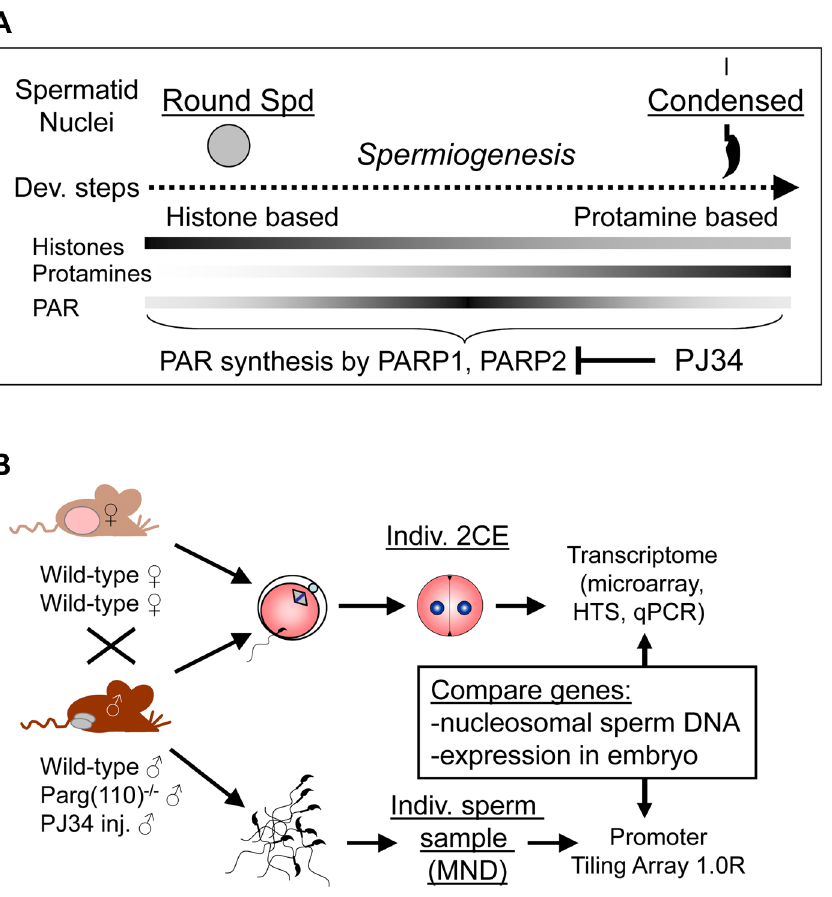
Figure 1. Experimental design to ascertain the impact of sperm chromatin structure on early embryonic gene expression. (A) Efficiency of histone-to-protamine exchange in spermiogenesis depends in part on levels of poly(ADP-ribose) (PAR) formed transiently by the interplay of PAR polymerases (PARP1, PARP2) and PAR glycohydrolase (PARG). Inhibition of PAR synthesis by PJ34 or disruption of normal PARG activity in the Parg (110) 2 / 2 mouse leads to abnormal chromatin remodeling with retention of histones in sperm [29]. (B) Natural mating of Parg (110) 2 / 2 males or males treated with PJ34 with wild-type control females was used to obtain 2-cell stage embryos (2CE) for genome-wide transcriptional profiling at the individual embryo level using microarrays and high throughput sequencing (HTS). Cauda epididymal sperm from the fathers were used to identify genes associated with nucleosomes rather than protamines using micrococcal nuclease digestion (MND). Aberrant histone association of gene loci with differential expression of genes in two-cell embryos was assessed and compared to embryo expression